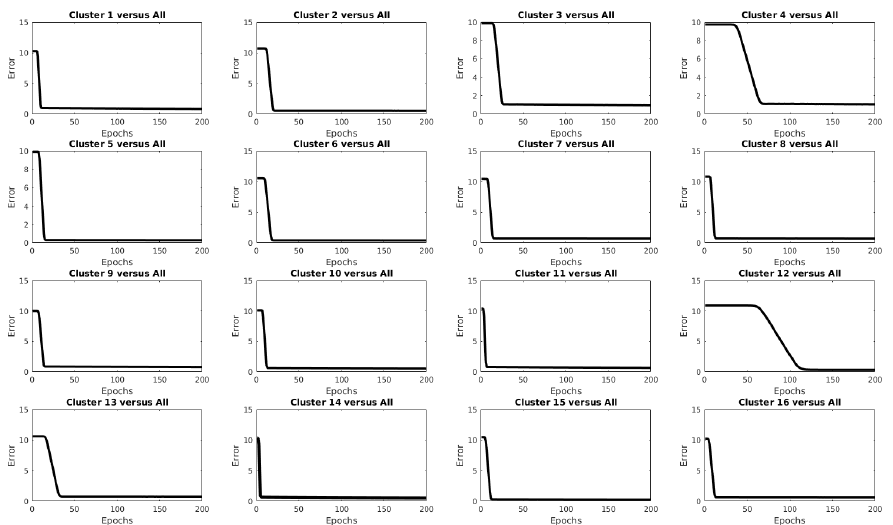
Figure 7. Error versus epoch curve of each one-versus-all case for the Indian pines image. Only the first 200 training epochs are shown